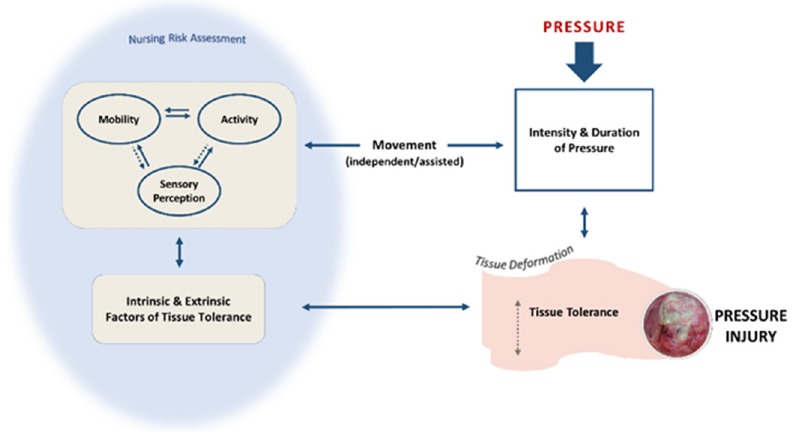
Figure 1. Influence of Mobility, Activity, and Sensory Perception Risk Assessment Dimensions and Movement on Pressure Intensity and Duration and Pressure